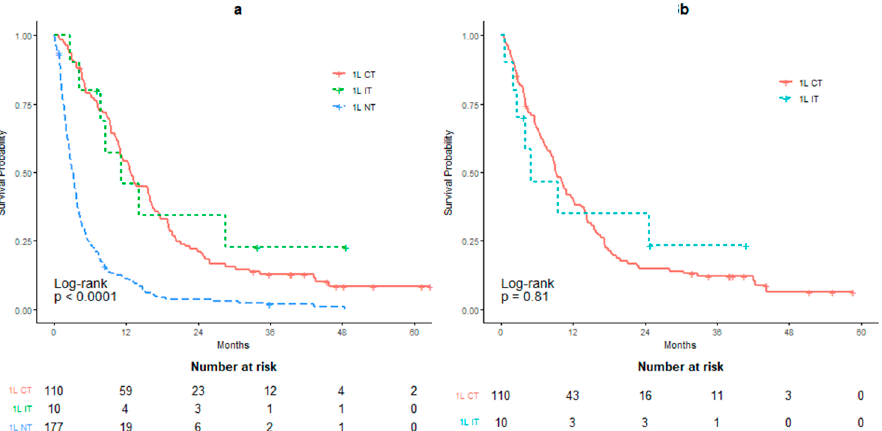
6 Figure 2. Overall survival in patients receiving palliative therapies, calculated from date of metas- tasis. Chemotherapy (CT), immunotherapy (IT), chemotherapy and immunotherapy (both) or no treatment (NT). The survival for 1L therapy, calculated from time of metastasis, is illustrated in Fig- ure 3a. The mOS for the NT group was significantly shorter compared to either the IT or